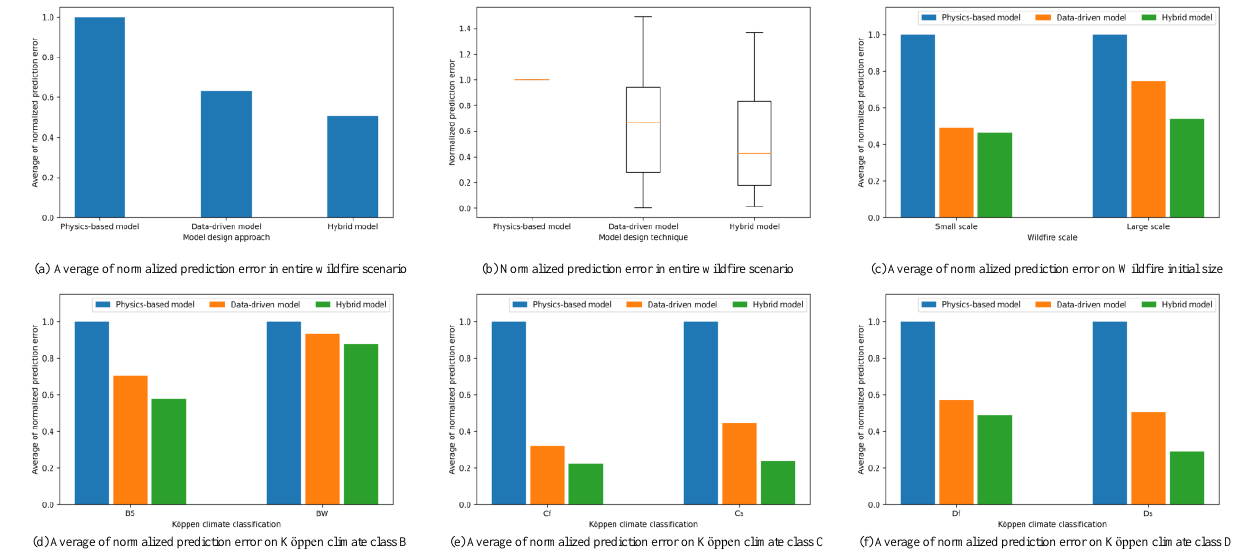
Figure 10. The simulation results on prediction accuracy.